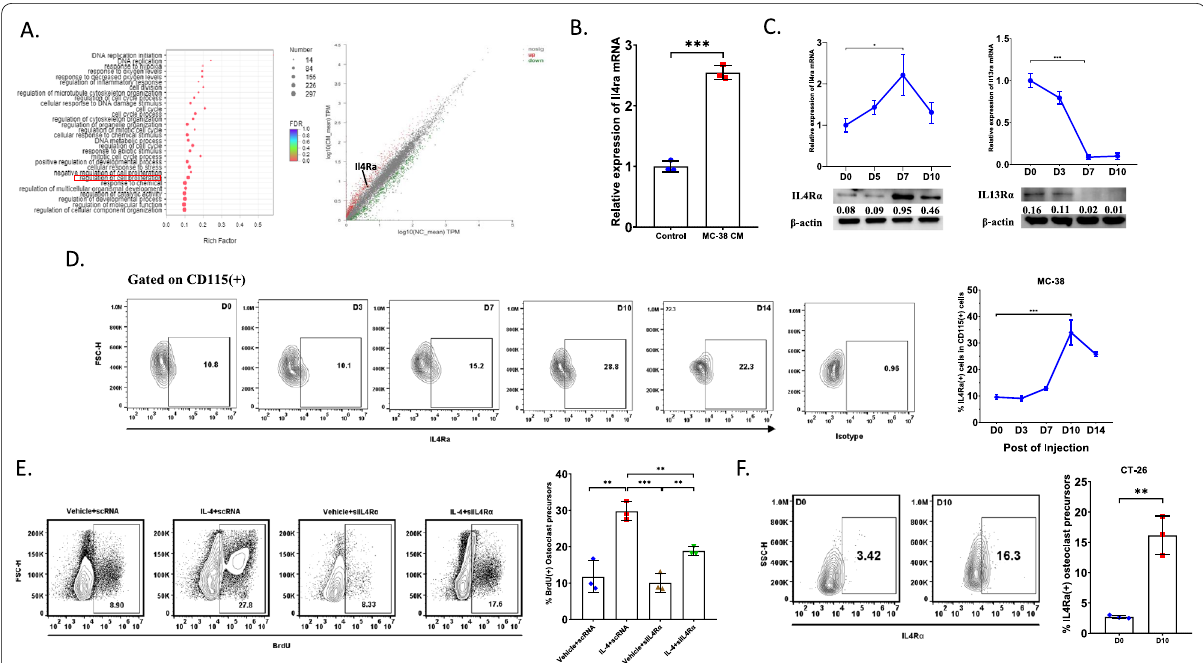
Fig. 3 IL4Rα regulating the proliferation of early OCPs in metastatic bone of CRC. A Transcriptomic profiling revealing most changed pathways analyzed by KEGG pathway analysis (left) and scatter plot showing the differentially expressed genes (right). B qRT‑PCR analysis detected the mRNA expression of IL4Rα in early OCPs cultured in MC‑38 conditioned medium. (n 3) C qRT‑PCR analysis and western blots showing the mRNA level = and protein level of IL4Rα or IL13rα in early OCPs isolated from bone marrow at each timepoint after injection of MC‑38 cells. (n 3–5 per condition, = each sample was pooled from 3 mice) D Flow cytometry plots and quantification of the percentage of IL4Rα ( ) early OCPs isolated from bone + marrow at each timepoint after injection of MC‑38 cells. (n 6–9 per condition) E Flow cytometry plots and quantification of percentage of = BrdU( ) OCPs cultured in MC‑38 CM after treated by recombinant IL‑4 protein with/without transfection with IL4Rα‑siRNA. (n 3) F Flow cytometry + = plots and quantification of the percentage of IL4Rα ( ) early OCPs isolated from bone marrow at D0 and D10 after injection of CT‑26 cells. (n 3) + = *p < 0.05, **p < 0.01, ***p <